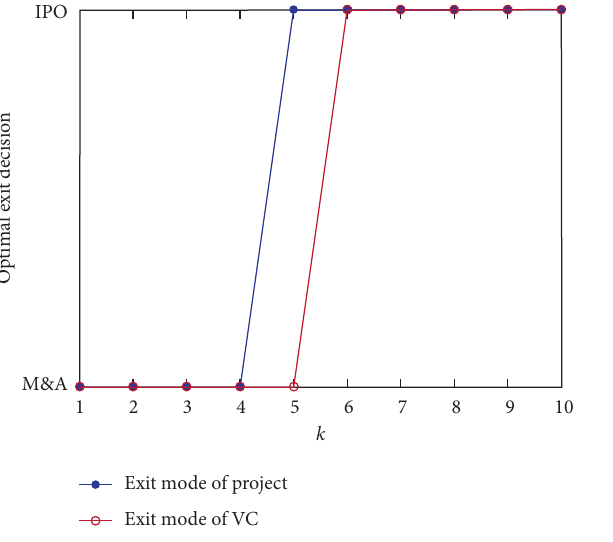
Figure 10: Optimal exit decision ( k � 3 ) .